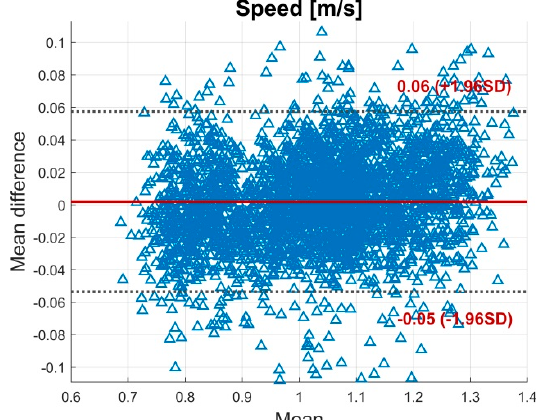
Figure A4. BA plot for the speed. The plot contains all calculated data points of all subjects. The solid line indicates the mean difference. The dashed lines indicate the LoA (95% CI of the mean difference).